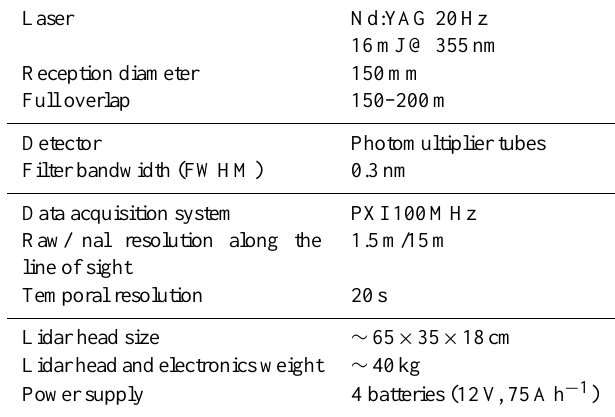
Table 1. GBML main technical